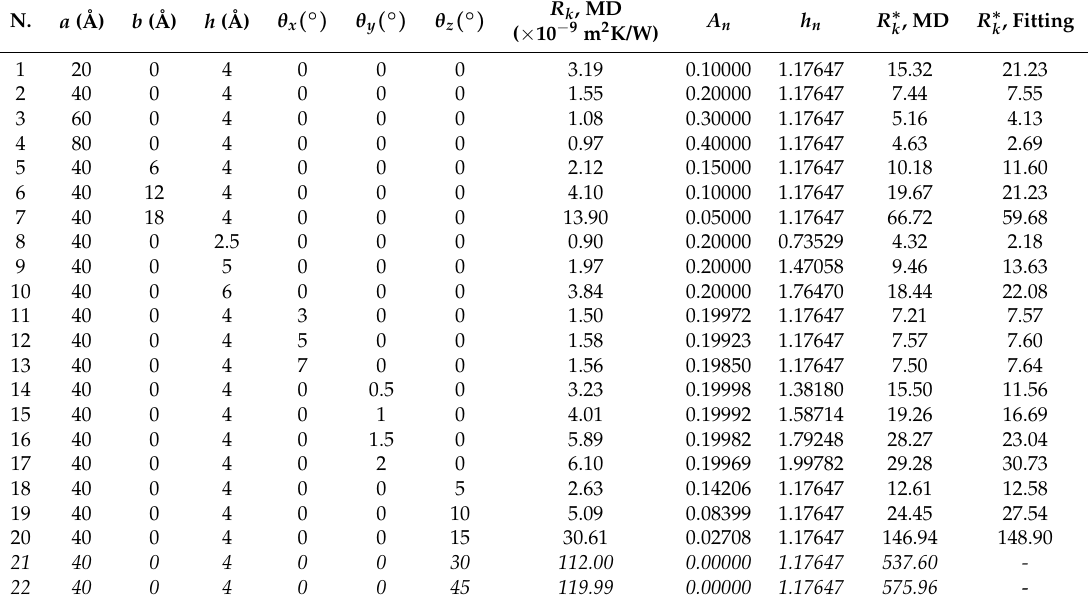
Table A1. List of Molecular Dynamics (MD) and fitting (Equation (5)) results of R k at the GNR-GNR interface, as illustrated in the setup in Figure 1. Notice that the correlation in Equation (5) has been fitted against the results of configurations N. 1–20; whereas, configurations N. 21 and 22 highlight the range of validity of the correlation, that is A n > 0 and R k (cid:46) 10 − 7 m 2 K/W.